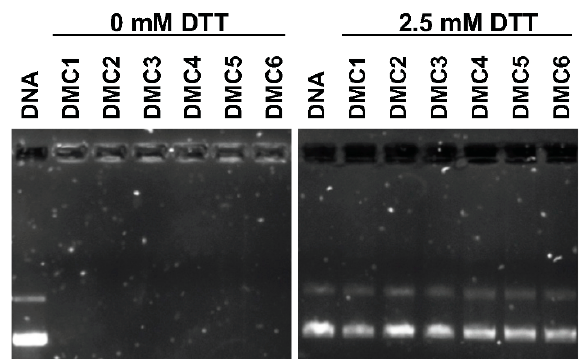
Figure 3. Agarose gel electrophoresis of polyplexes ( w / w = 48) treated without DTT ( left ) and with 2.5 mM DTT ( right ).